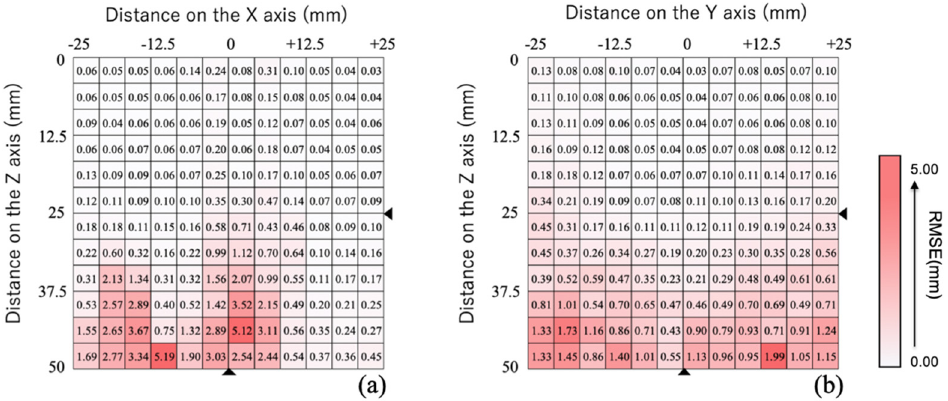
Figure 11. Errors of the estimated position for the ( a ) XZ and ( b ) YZ planes.